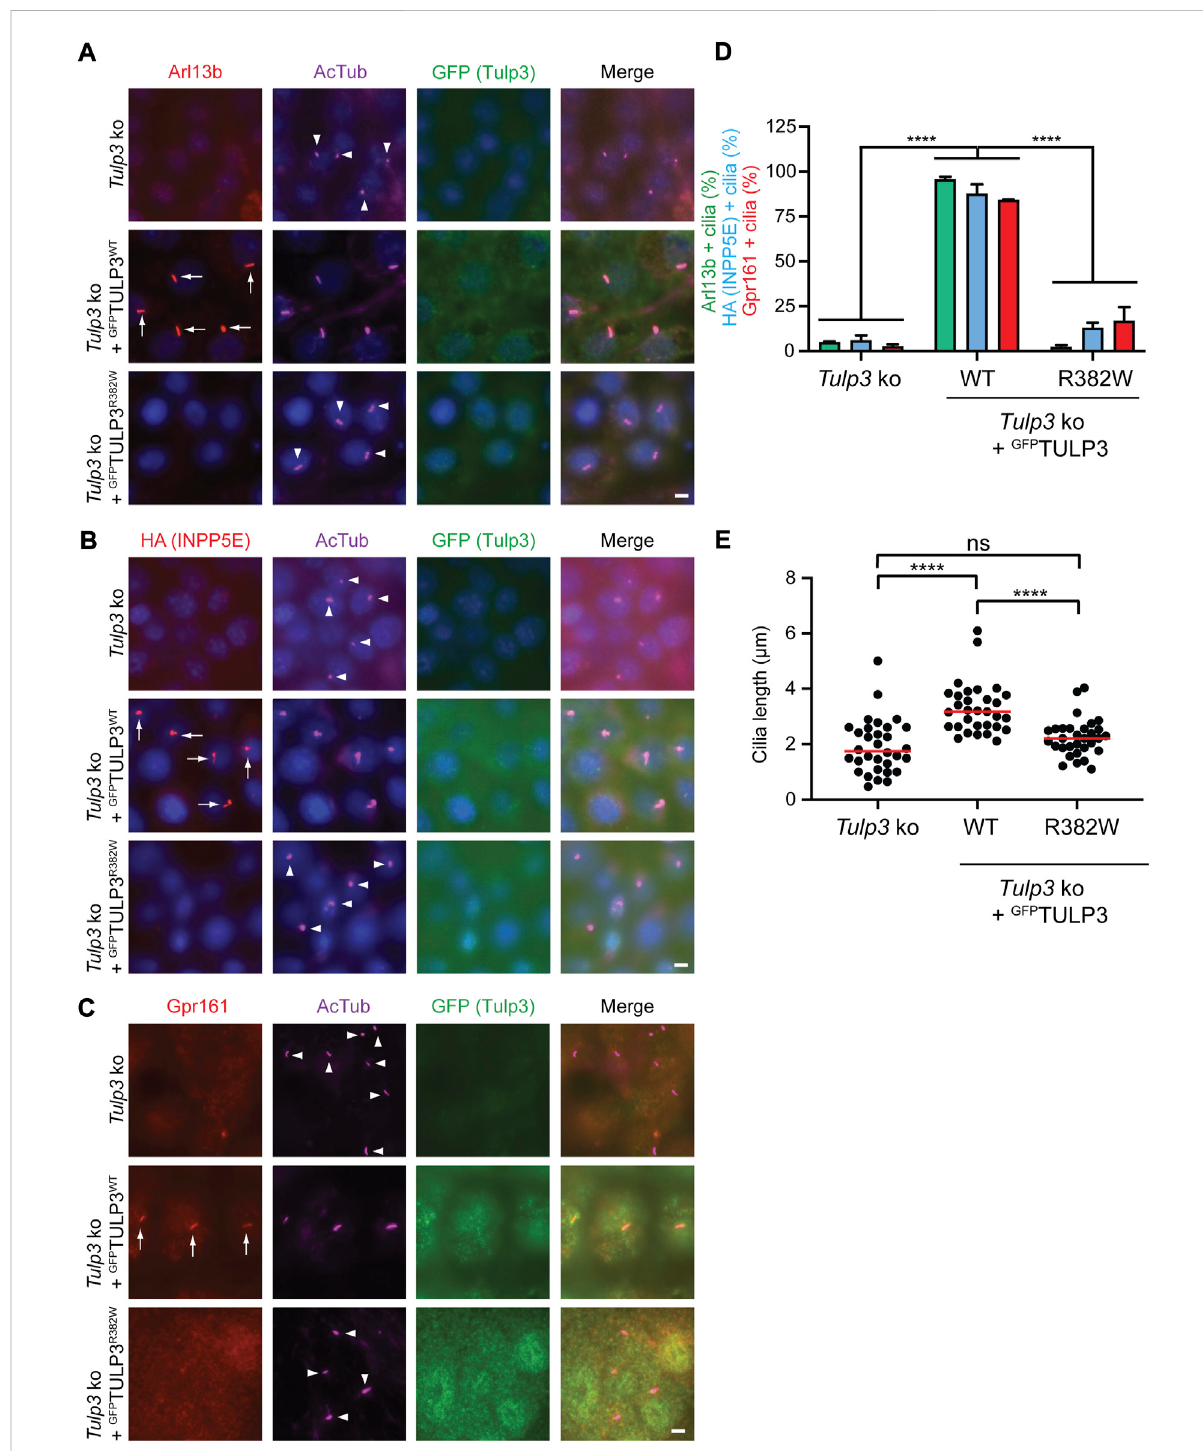
Analysis of the TULP3 R382W variant in ciliary traf fi cking. (A) -C. Tulp3 ko IMCD3 parental line or lines stably expressing HA-INPP5E and LAP- tagged wild type TULP3 or R382W mutant were grown to con fl uence, serum starved for 36 h before fi xation and immune-stained for Arl13B (A) , HA (B) or Gpr161 (C) and GFP, acetylated tubulin (AcTub) and counterstained for DNA. Arrows and arrowheads indicate cilia positive or negative for the indicated proteins, respectively. Scale = 5 μ m. (D) . Ciliain GFP(TULP3) expressing cells counted from atleast 2 experiments, n > 200/condition. Data represents mean ± SD. **** p < 0.0001, two-way ANOVA followed by Tukey multiple comparison test. (E) . Cilia lengths (n = 30 cilia/condition). **** p < 0.0001; ns, not signi fi cant by using one-way ANOVA followed by Tukey multiple comparison